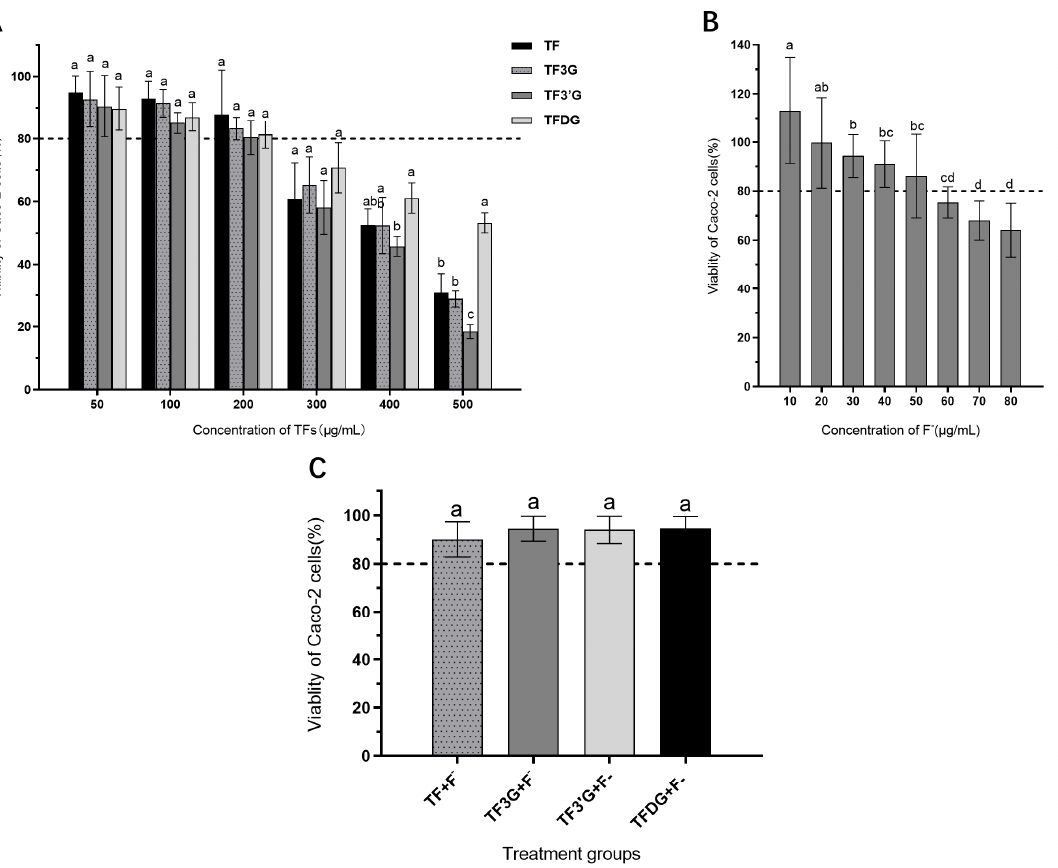
Figure 2. Effects of TFs and F − treatment on the viability of Caco-2 cells. ( A ) Caco-2 cell viability treated with different concentrations of TFs for 24 h. ( B ) Caco-2 cell viability under different concen- trations of F − for 24 h. ( C ) Caco-2 cell viability treated with TFs + F − mix for 4 h. Different lowercase letters in the same group indicate significant differences at p < 0.05.